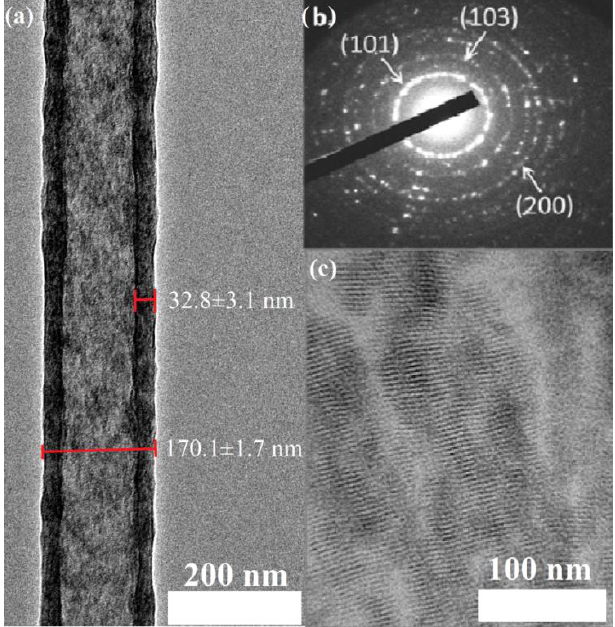
Figure 1. ( a ) TEM micrograph showing the high uniformity and reproducibility of the electrospun hollow TiO nanotube diameter and wall thickness, each with very small 2 standard deviations; ( b ) Electron diffraction pattern indicating the presence of anatase TiO ( c ) TEM micrograph of the standalone PbSe